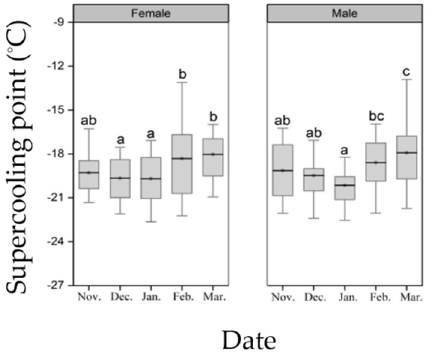
Figure 2. Seasonal change of supercooling point of H. cunea diapausing pupae. Different letters indicate significant differences from one another at p ˂ 0.05 (female: n = 16–19; male: n = 19–22). The top and bottom of each box represents the upper and lower quartile, respectively; the horizontal line represents the mean; the vertical lines extend to the minimum and maximum values within 1.5 times the inter-quartile